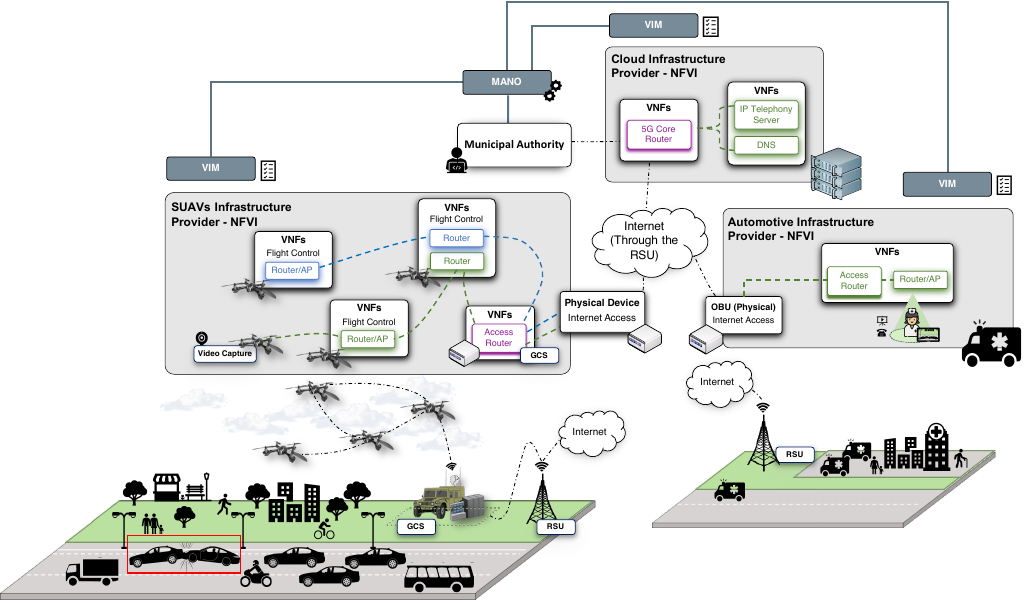
Figure 4. Emergency situation: a complementary network service is deployed to handle the